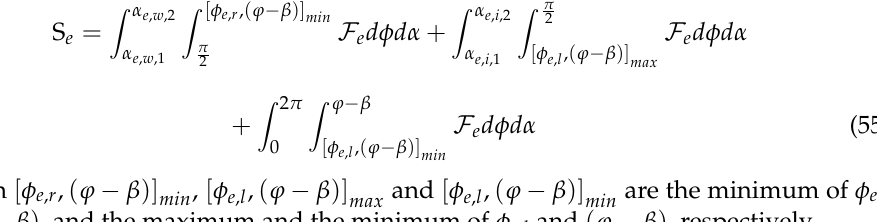
Figure 17. Schematic diagram for the calculation of 𝑆 (cid:3032) while ϕ (cid:3032),(cid:3039) < 𝜋 2⁄ < ϕ (cid:3032),(cid:3045) and β ≤ ϕ (cid:3032),(cid:3039) + 𝜑 . If the axis 𝑌 is between the points A and B, it should be mentioned that the third term of Equation (55) on the right-hand side is equal to zero and 𝑆 ((cid:2875)) will not exist any- more.